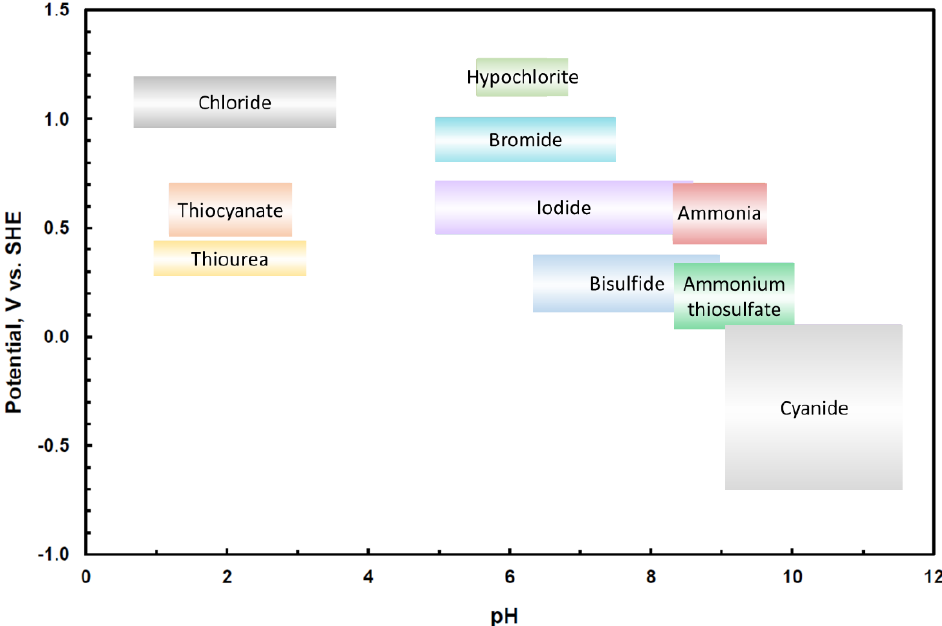
Figure 3. Typical potential [V vs. Standard hydrogen electrode (SHE)] and pH operating regions for gold lixiviants, redrawn after [32].